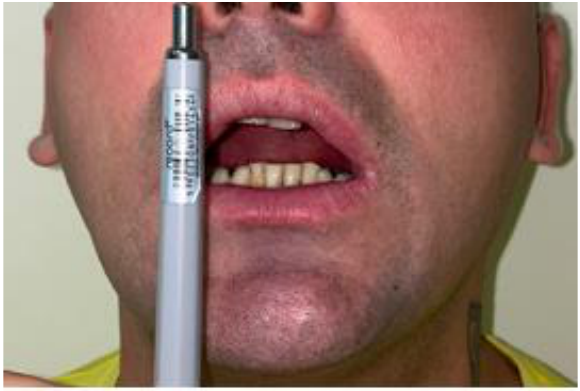
Figure 16. Limited mouth opening due to temporal muscle scarring and contraction.